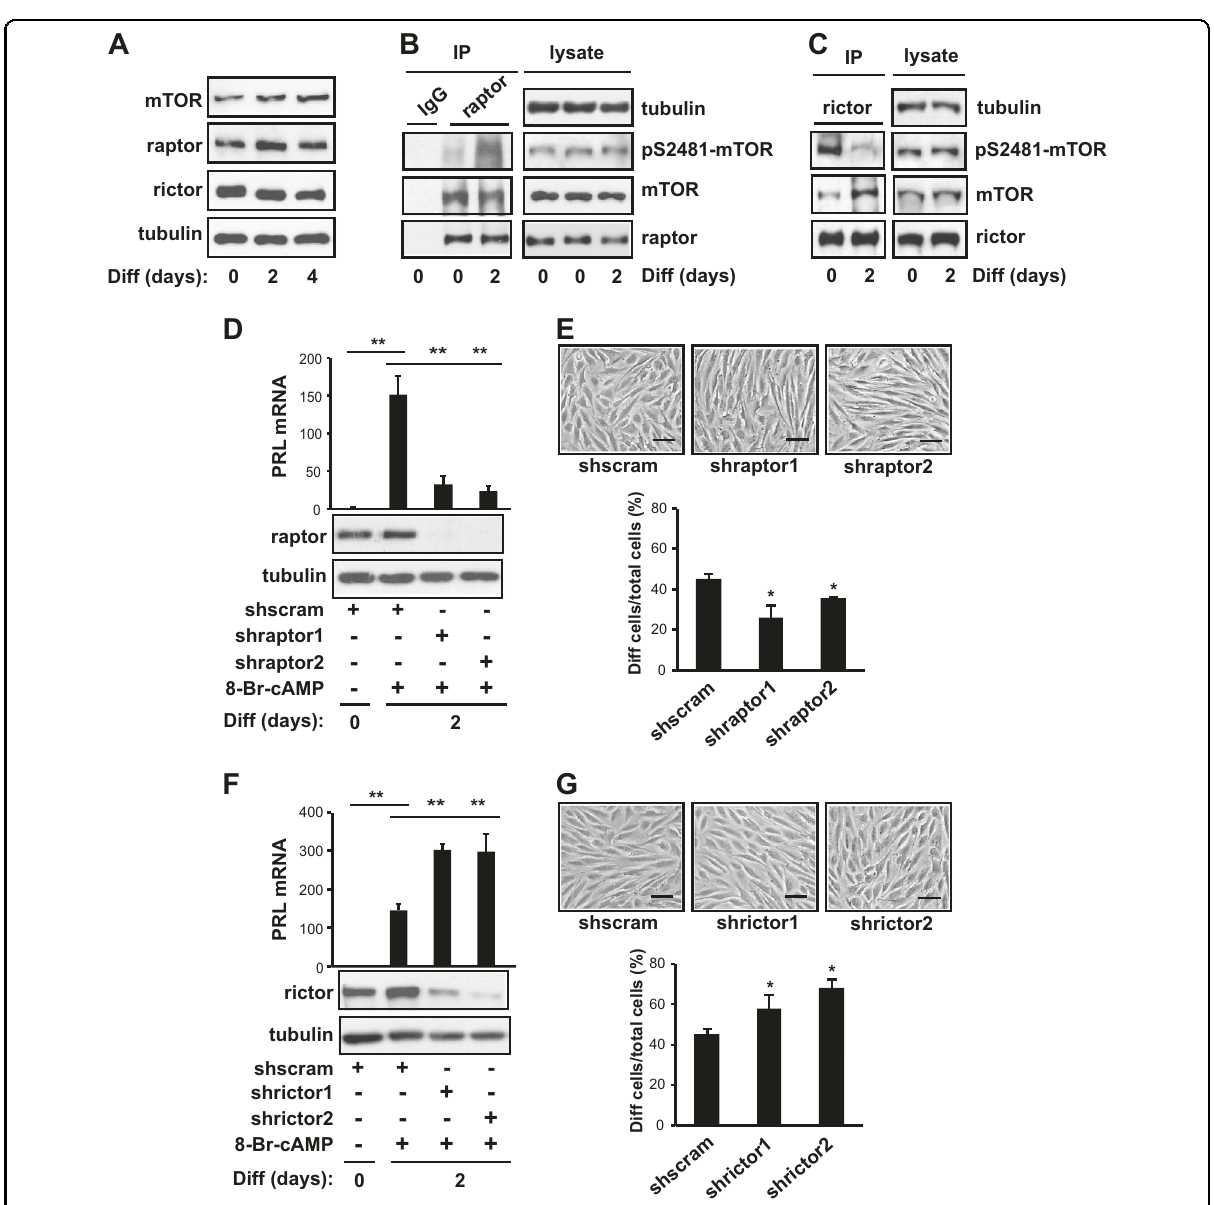
Fig. 1 mTORC1 and mTORC2 differentially regulate 8-Br-cAMP-induced decidualization. a Human endometrial stromal (hES) cells were induced to differentiate for 4 days in the presence of 0.5 mM 8-Br-cAMP. On day 0, 2, or 4 of differentiation, the cells were lysed and subjected to western blotting. b , c On day 0 or 2 of differentiation, the cells were lysed, subjected to immunoprecipitation against raptor ( b ) or rictor ( c ) and were analyzed by western blotting. d – g hES cells were infected with lentiviruses expressing two different raptor shRNAs ( d , e ), rictor shRNAs ( f , g ), or scrambled shRNA. They were then selected by puromycin for 5 days and differentiated for 2 days in the presence of 0.5 mM 8-Br-cAMP. d , f The cells were lysed and analyzed by either quantitative RT-PCR or western blotting. Human GAPDH was used to normalize gene expression. e , g Cells were photographed under bright- fi eld illumination. Round-shaped cells were scored as differentiated cells. Scale bar = 50 μ m. a – g Data are representative of three to four independent experiments. d - g Data are expressed as the mean ± SD, with paired t -tests performed as indicated. * P < 0.05, ** P <